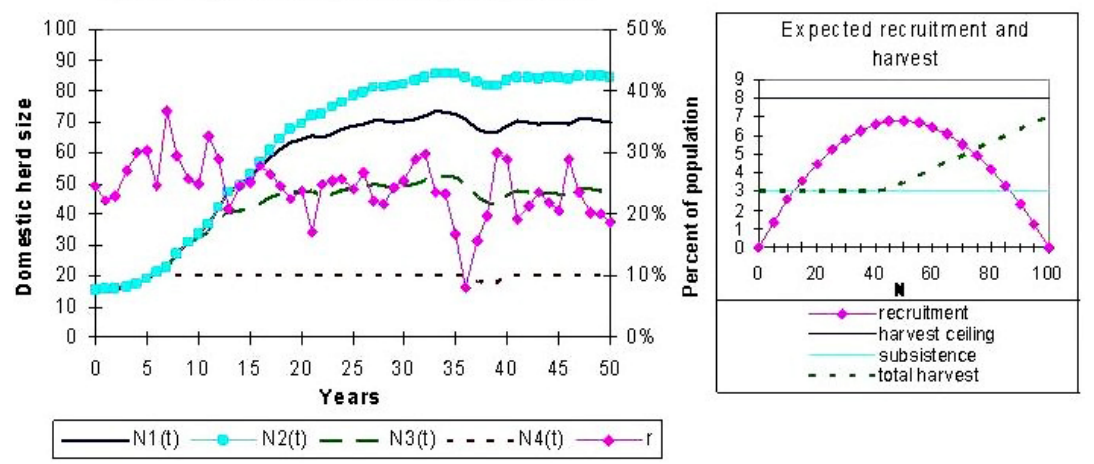
Fig. 5. . Dynamics of a domestic Rangifer population (N) with autocorrelated random, density-dependent recruitment parameter r (right axis) under harvest rules representing different husbandry objectives (N1: target harvest = 7% of N, N2: maximum herd growth, N3: maximum sustained yield, N4 = target herd size of 20). In this example, K = 100, mean r = 25%, with coefficient of variation = 0.15 and r = 0.3; subsistence harvest = 3, and upper limit of 5 on non-subsistence harvest. Right panel illustrates non- random density-dependent recruitment with the same parameter